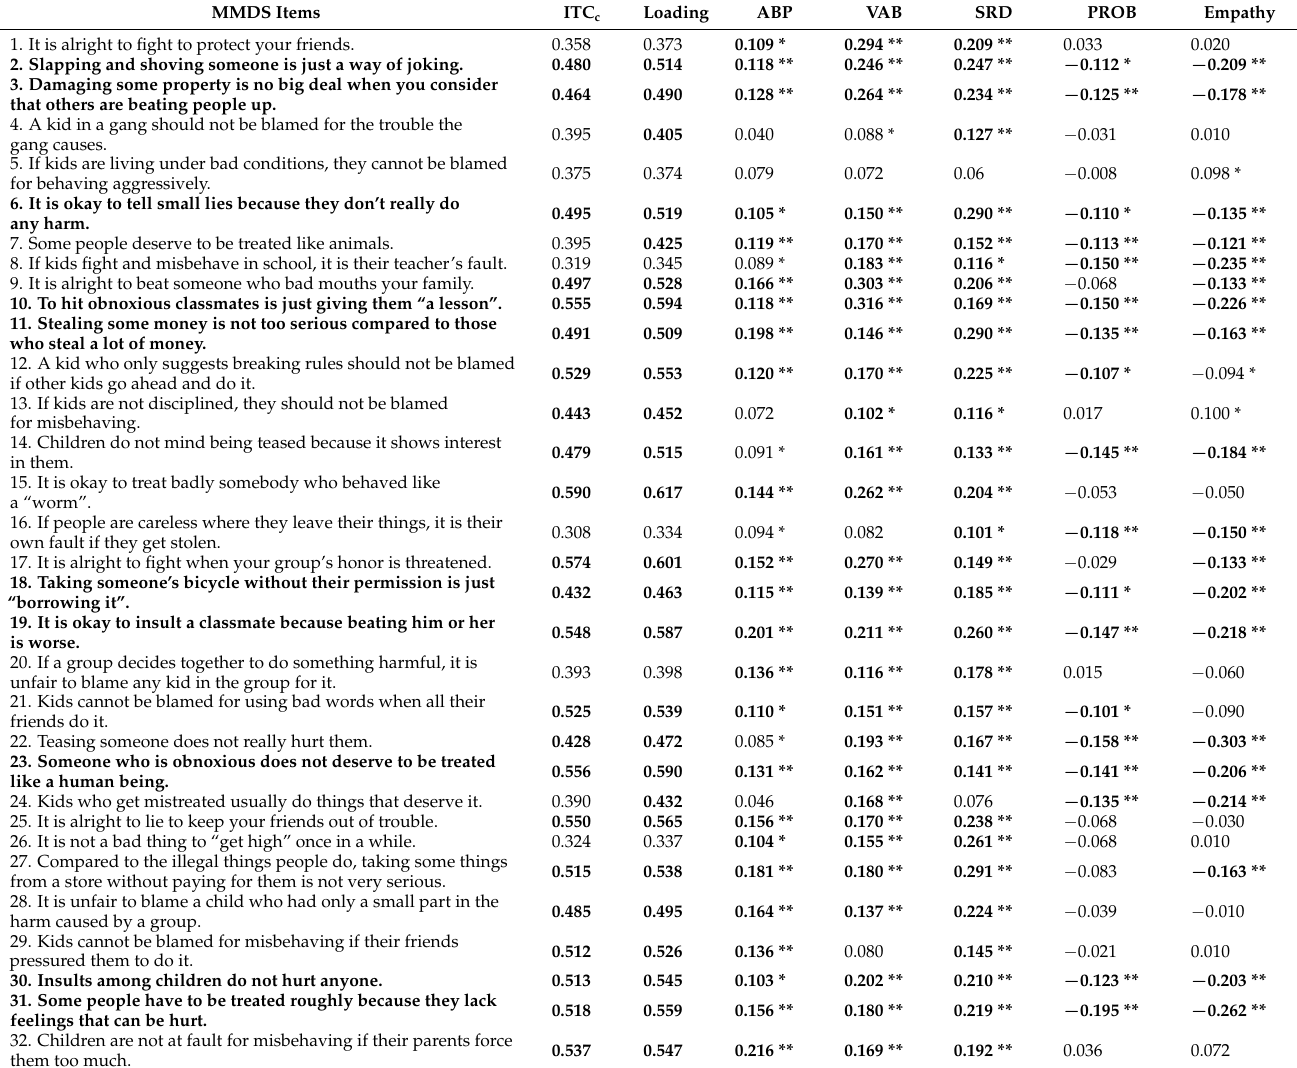
Table 5. Discrimination indices (ITCc), factor loadings, and validity indices of the MMDS